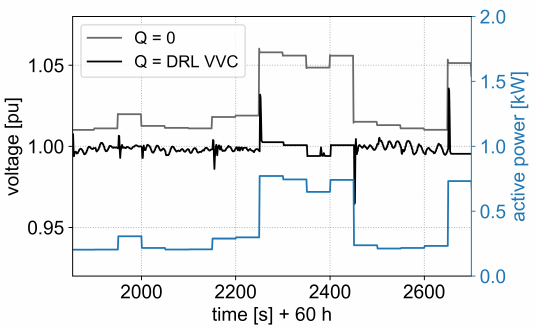
Figure 10. Dynamic voltage behavior at node N10 with and without DRL